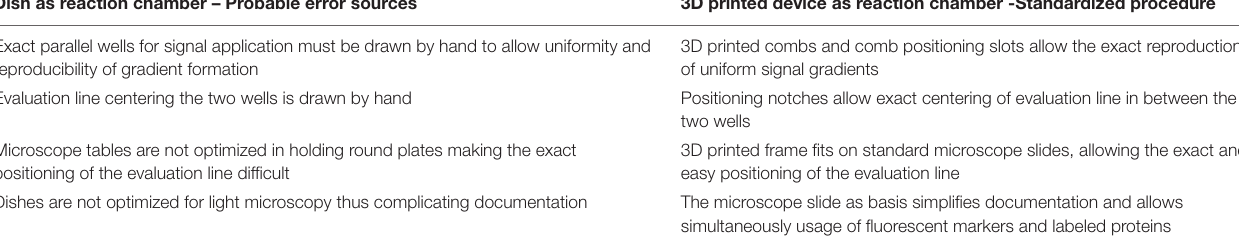
TABLE 1 | Improvement of the chemotropic assay by the newly designed 3D printed device. Dish as reaction chamber – Probable error sources 3D printed device as reaction chamber -Standardized procedure